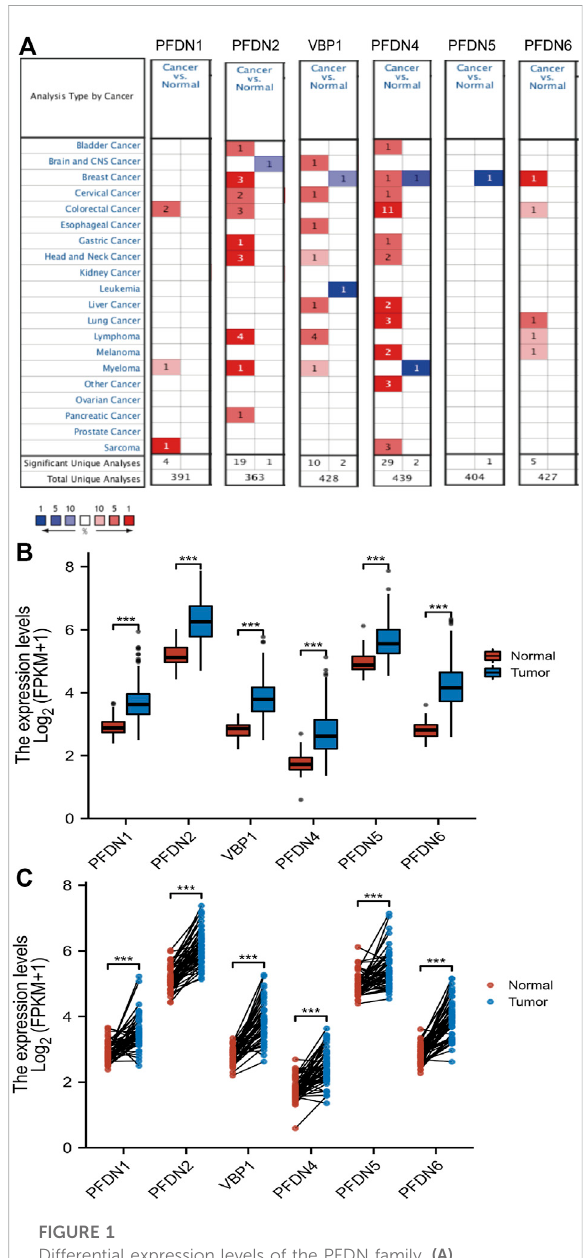
FIGURE 1 Differential expression levels of the PFDN family. (A) Transcription levels of the PFDN family in different cancers (Oncomine). (B,C) Expression levels of the PFDN family in